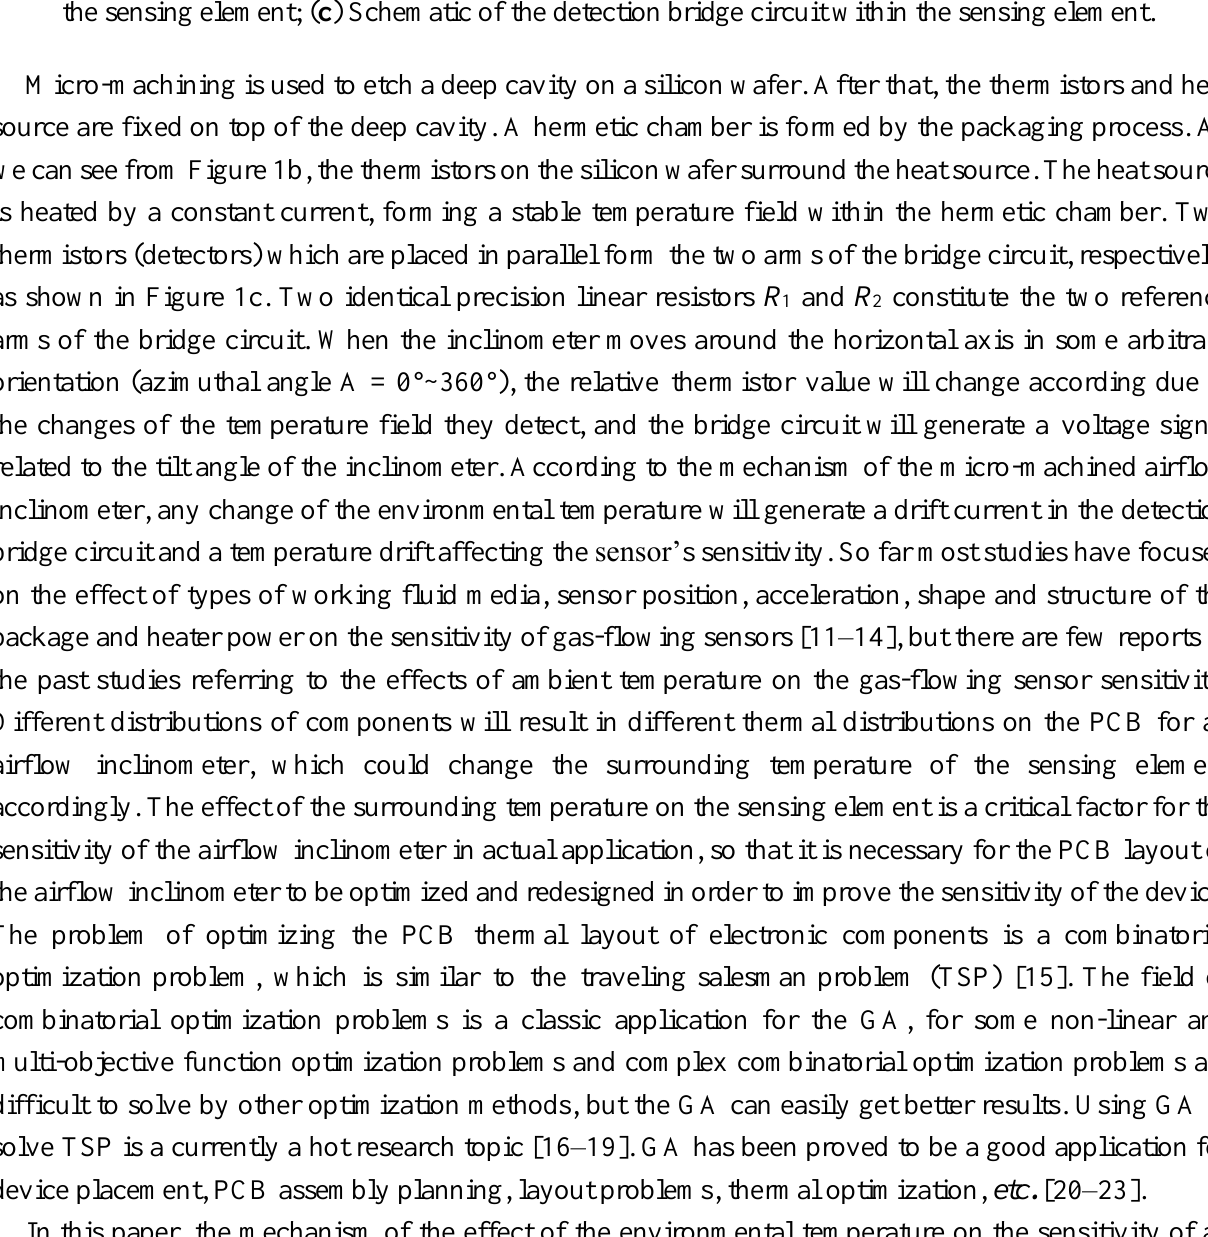
Figure 1. Schematic diagram of the structure of the sensing element for a micro-machined airflow inclinometer. ( a ) Schematic diagram of the sensing element; ( b ) Platform diagram of the sensing element; ( c ) Schematic of the detection bridge circuit within the sensing